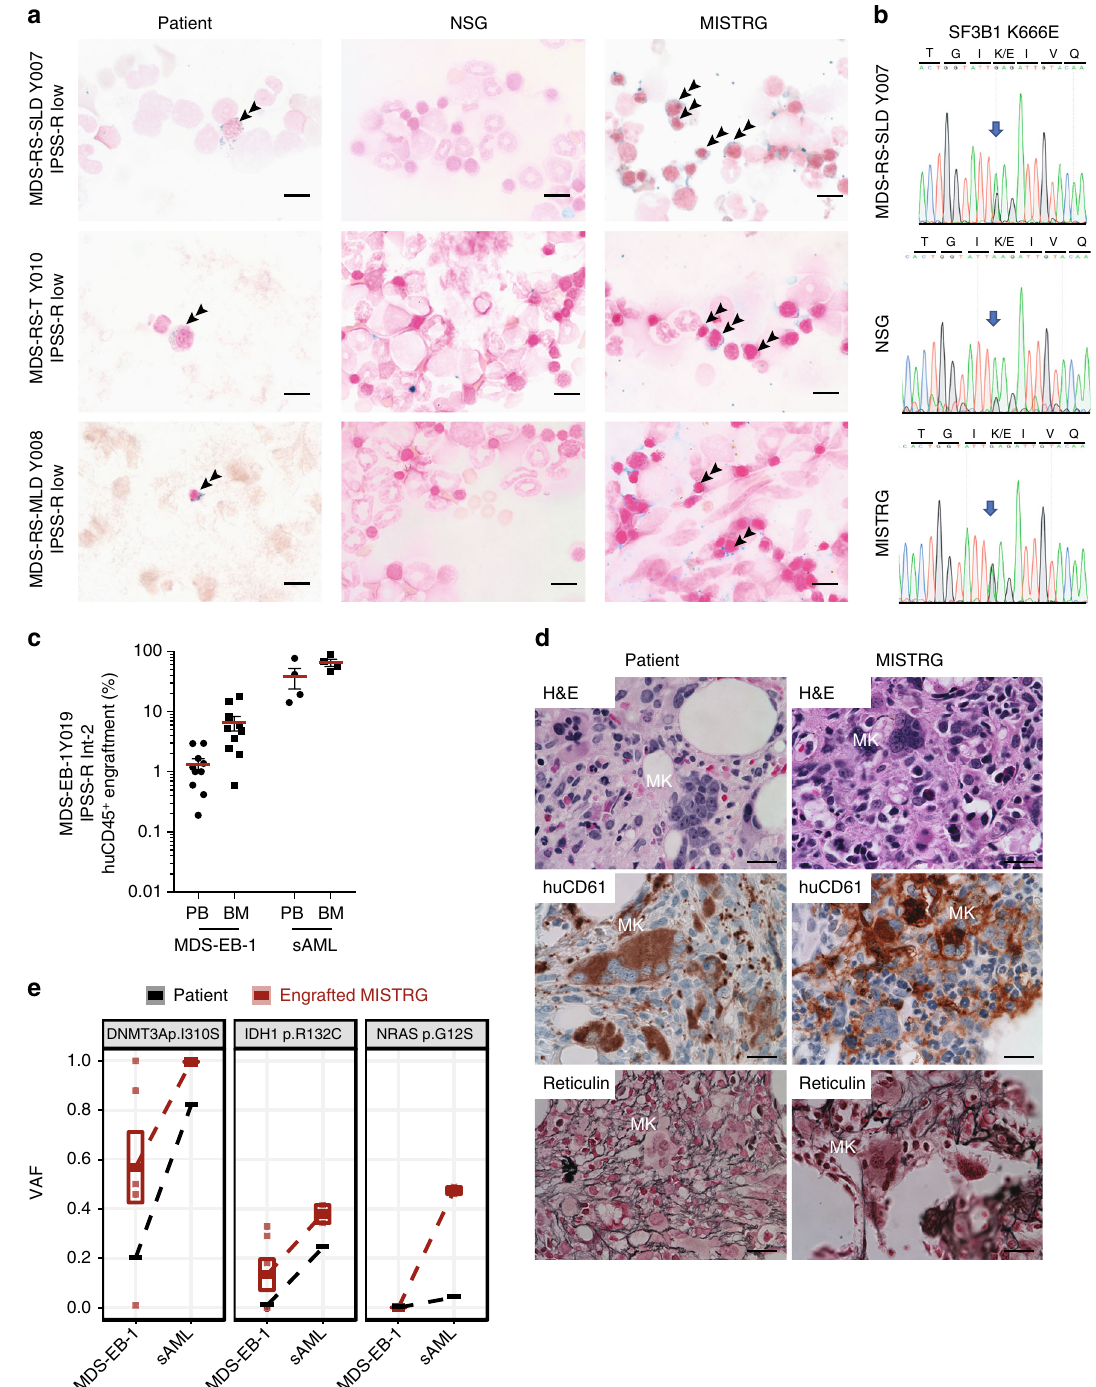
Fig. 4 MISTRG replicate myelodysplasia and clonal evolution upon disease progression. a NSG and MISTRG were engrafted with low and int-1 risk Sf3B1 mutant myelodysplastic syndrome (MDS) with ring sideroblasts (see Figs. 2, 3) and patient and NSG and MISTRG xenografts were stained with Prussian blue iron stain (scale bars 10 µ m, original magni fi cation 60×). b SF3B1 mutation was veri fi ed in the patient ’ s and representative NSG and MISTRG xenografts by Sanger sequencing. c – e MISTRG engrafted with consecutive MDS-EB-1 and secondary acute myeloid leukemia (sAML) samples from the same patient (Y019 and Y028, respectively). c Overall (huCD45 + ) engraftment in peripheral blood (PB) and bone marrow (BM). Individual mice are represented by symbols, with means ± S.E.M. d Histology from MDS-EB-1 (Y019) diagnostic BM and representative engrafted MISTRG BM. Hematoxylin and eosin (H&E) and huCD61 stains reveal human megakaryocytic dysplasia and reticulin stain reveals bone marrow fi brosis (high-power magni fi cation scale bars 20 µ m). e Targeted exome sequencing results from MISTRG xenografted with same patient ’ s primary MDS-EB-1 diagnosis samples and sAML at the time of disease progression. For each mutation, variant allele frequencies (VAFs) are shown for the patient (black) and representative MISTRG (red) mice with engraftment levels >1%. Mean VAF values between MDS-EB-1 and sAML are connected by